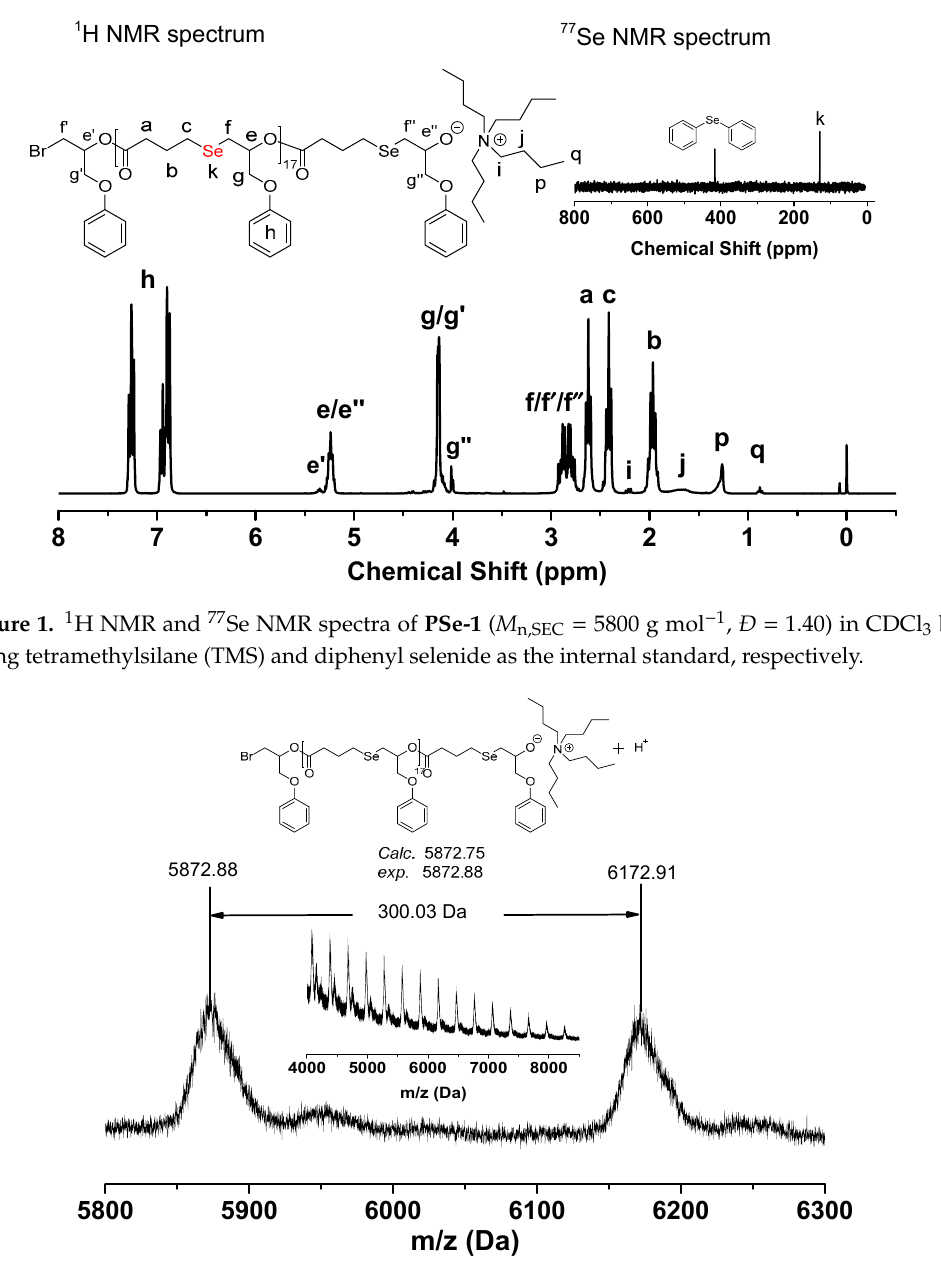
Figure 2. Matrix-assisted laser-desorption-ionization time-of-flight mass spectrometry (MALDI-TOF-MS) spectrum of PSe-1 ( M n,SEC = 5800 g mol − 1 , Ð = 1.40).